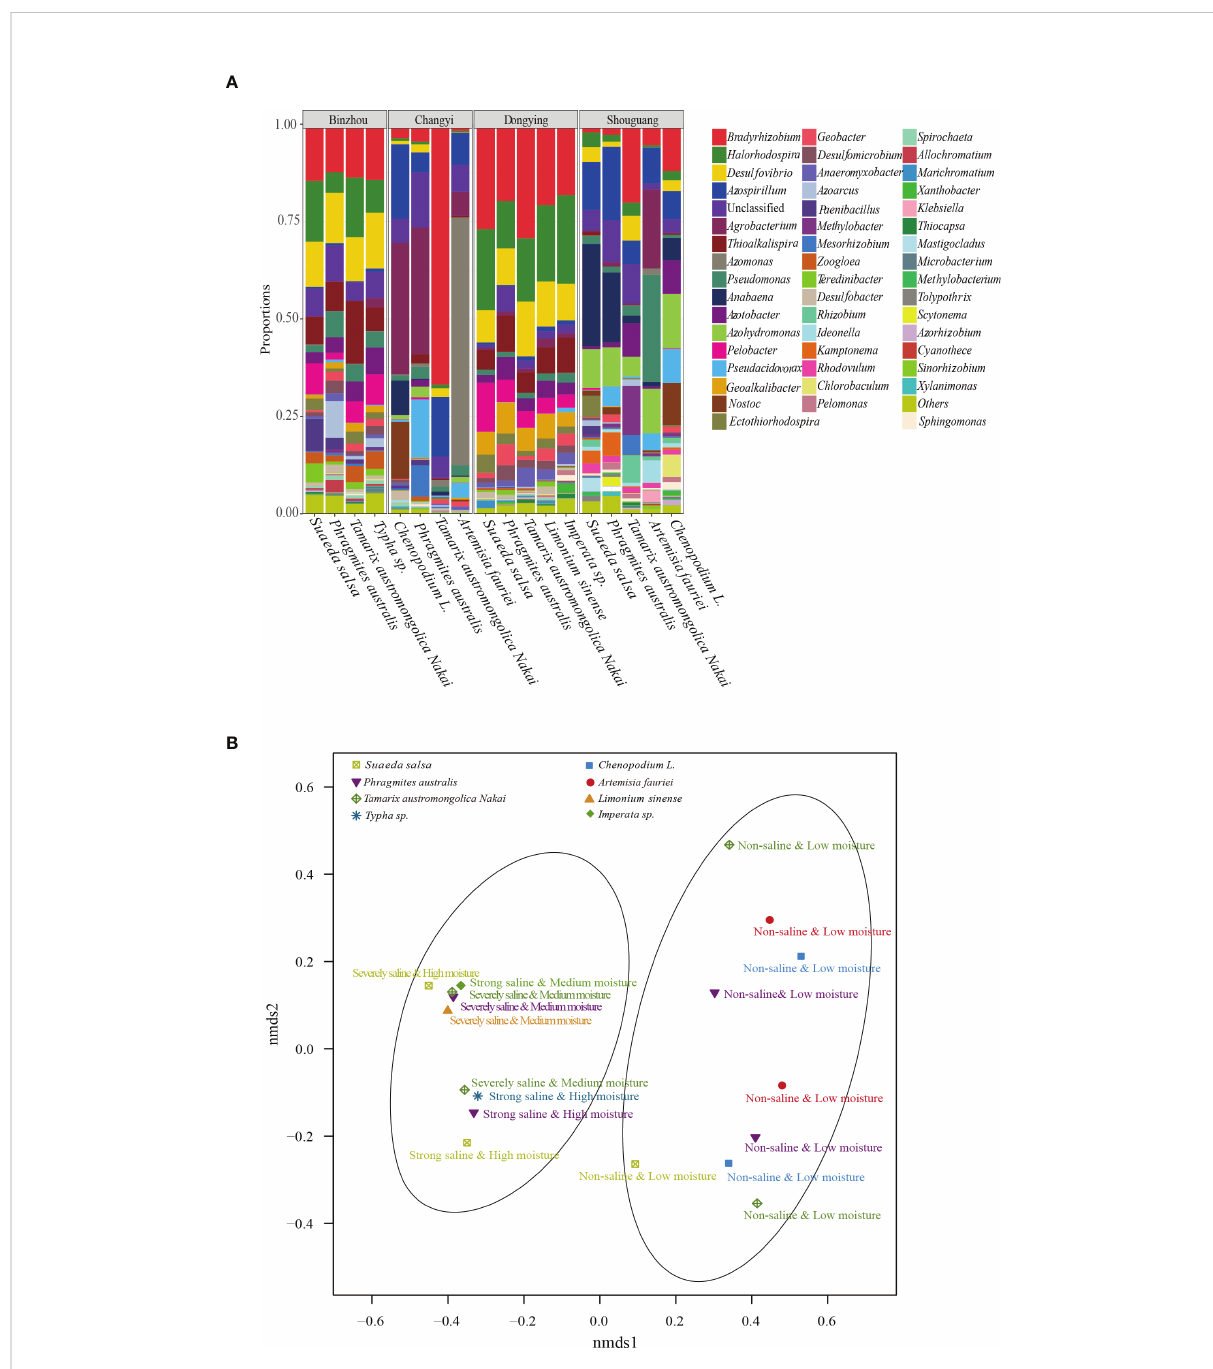
FIGURE 3 Diazotrophic community structure assays. (A) Diazotrophic genera in different soil samples collected from the four locations. Dominant diazotrophic genera with high relative abundance (>1%) were shown. (B) Non-metric multidimensional scaling analysis (nNMDS). The diazotrophic community dissimilarities based on OTUs from the nifH gene sequences were shown. All the samples were clearly divided into two groups based on soil salinity and moisture